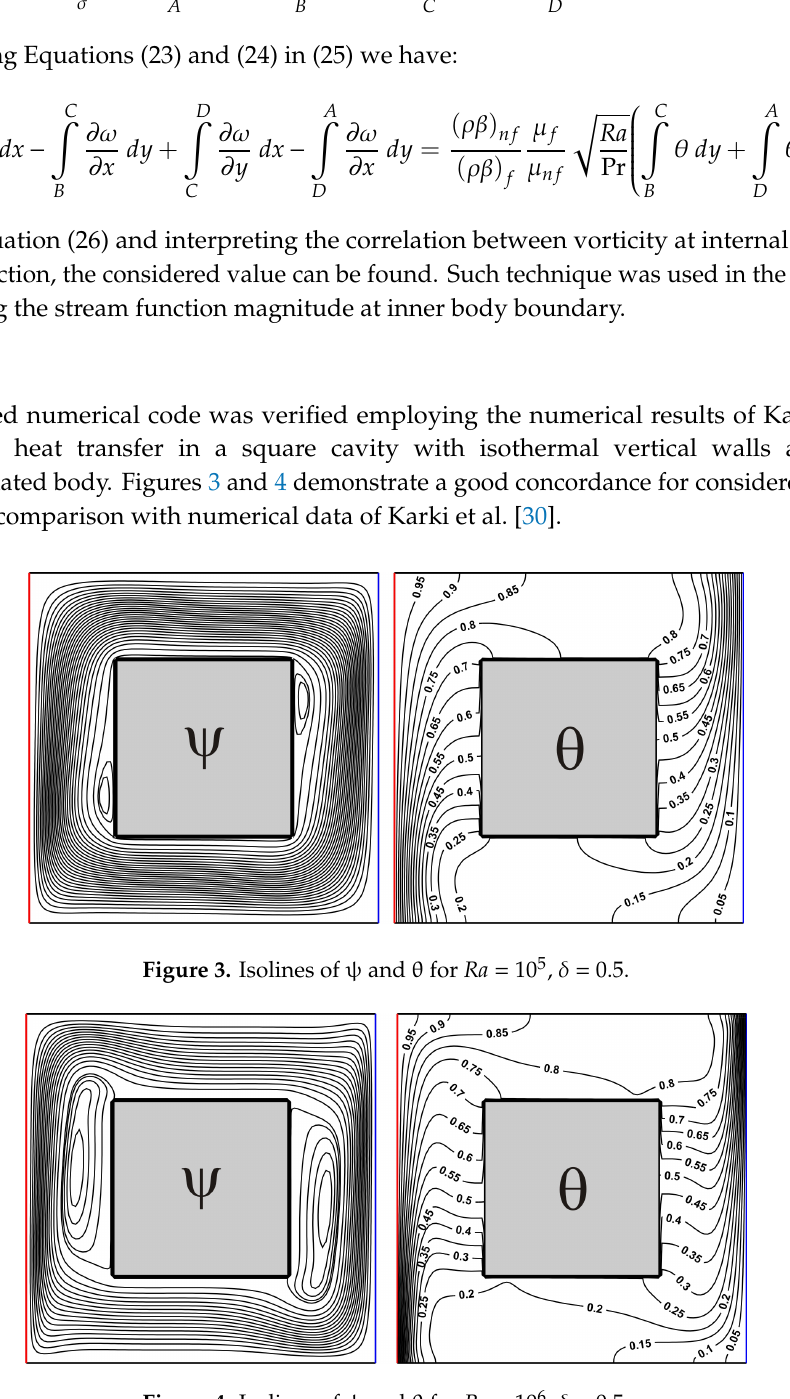
Figure 4. Isolines of ψ and θ for Ra = 10 6 , δ = 0.5.